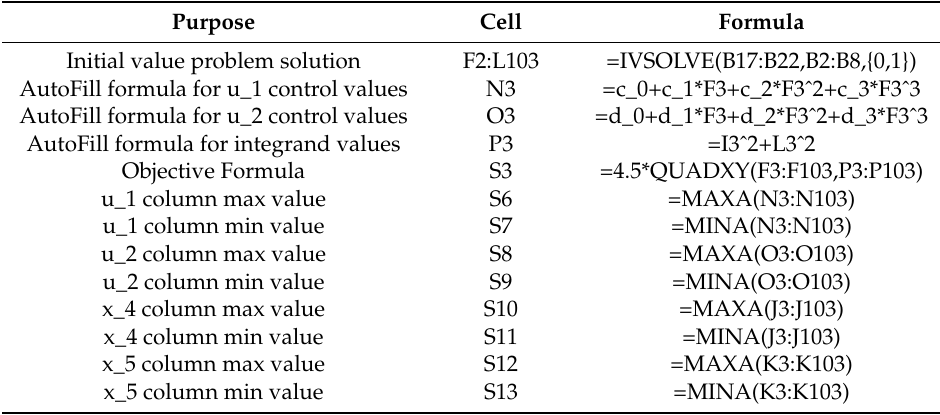
Table 3. Formulas definitions used for solving optimal control problem